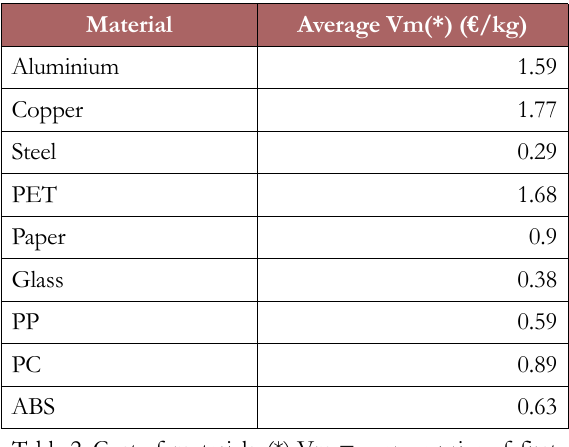
Table 2. Cost of materials. (*) Vm = average price of first production materials (Villalba, Segarra, Fernandez, Chimenos & Espiell, 2002)